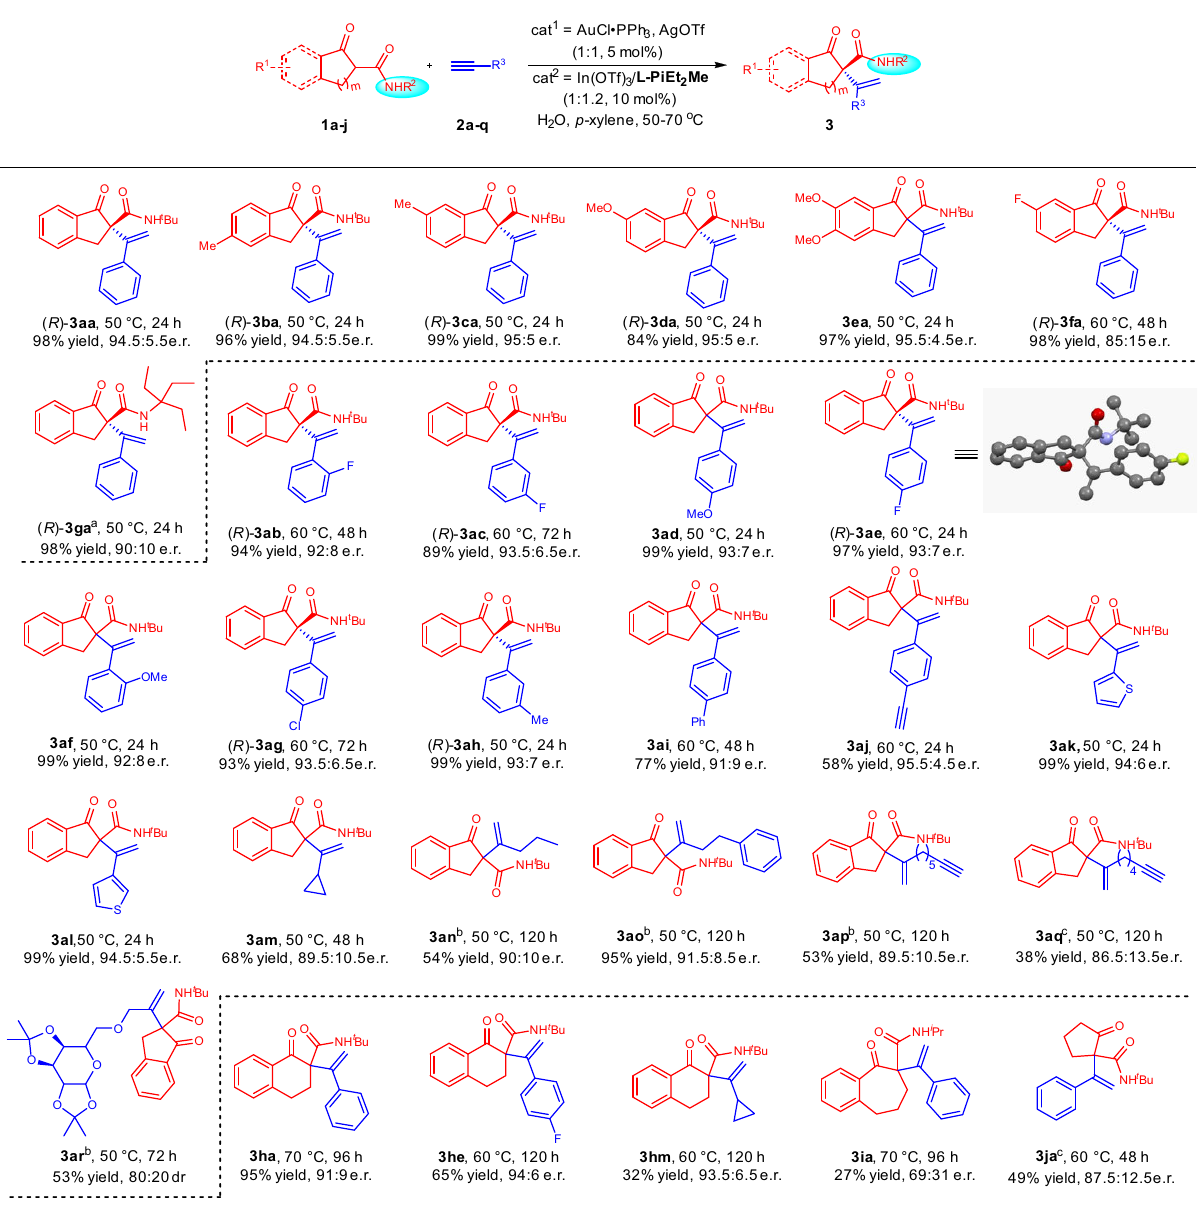
Fig. 2 Substrate scope of the reaction about β -ketoamides. Unless otherwise noted, all reactions were carried out, AuCl ∙ PPh 3 /AgOTf (1:1, 5 mol%), In (OTf) 3 / L-PiEt 2 Me (1:1.2, 10 mol%), 1 (0.10 mmol) and 2 (2.0 equiv), H 2 O (2 μ L) as additive in p -xylene (1.5 mL) at 50 – 70 °C for 24 – 120 h. Isolated yields. The e.r. values were determined by HPLC analysis on chiral column. a L-PiEt 2 was used as ligand. b 3.0 equiv of 2 was used. c L-PiMe 3 was used as ligand. was also tolerated, affording the product 3ja in moderate yield reason might be that the N -protecting group, amide moiety and with good enantioselectivity. The absolute con fi guration of 3ae backbones of the catalyst are included in discrimination of Re - was determined to be R by X-ray crystallographic analysis and the and Si -face of the 1,3-dicarbonyl compounds. With L-PiEt 2 Me as absolute con fi gurations of 3aa – 3ac and 3ag – 3ah were determined ligand, the bulky N -tertbutylamide moiety could help to shield to be R by comparison of the CD spectra with that of 3ae (Fig. 2). the Si -face of substrate 1a ef fi ciently. On the contrary, the N - benzyl or PMP with smaller steric hindrance showed poor ability to shield the Si -face of the 1,3-dicarbonyl compounds, causing the Effect of N -protecting group . Other easily removable N -pro- e.r. values of the products decreased sharply in the L-PiEt 2 Me /In tecting groups such as N -benzyl or N -PMP were investigated by (III) system. Changing to the L-TQ- ( S ) -EPh /In(III) system, the reacting with phenylacetylene (Table 2). The desired products 3ka steric hindrance of amide moiety and backbones of the catalyst and 3la were obtained in excellent yields but with only 56.5:43.5 e. increased, and the Si -face of the 1,3-dicarbonyl compounds could r. and 72.5:27.5 e.r. under standard conditions. After changing the also shield better; therefore, the e.r. values of products increased. ligand to L-TQ- ( S ) -EPh derived from ( S )-tetrahydroisoquinoline- 3-carbonyl acid and ( S )-phenylethanamine, adjusting the reaction Substrate scope of the reaction about β -ketoesters . When temperature and solvent, the enantioselectivities were improved β -ketoesters 4a was applied in the In(OTf) L-PiEt 2 Me catalytic sharply to 90:10 e.r. and 89:11 e.r., respectively. The possible 3 / NATURE COMMUNICATIONS| (2021) 12:3012